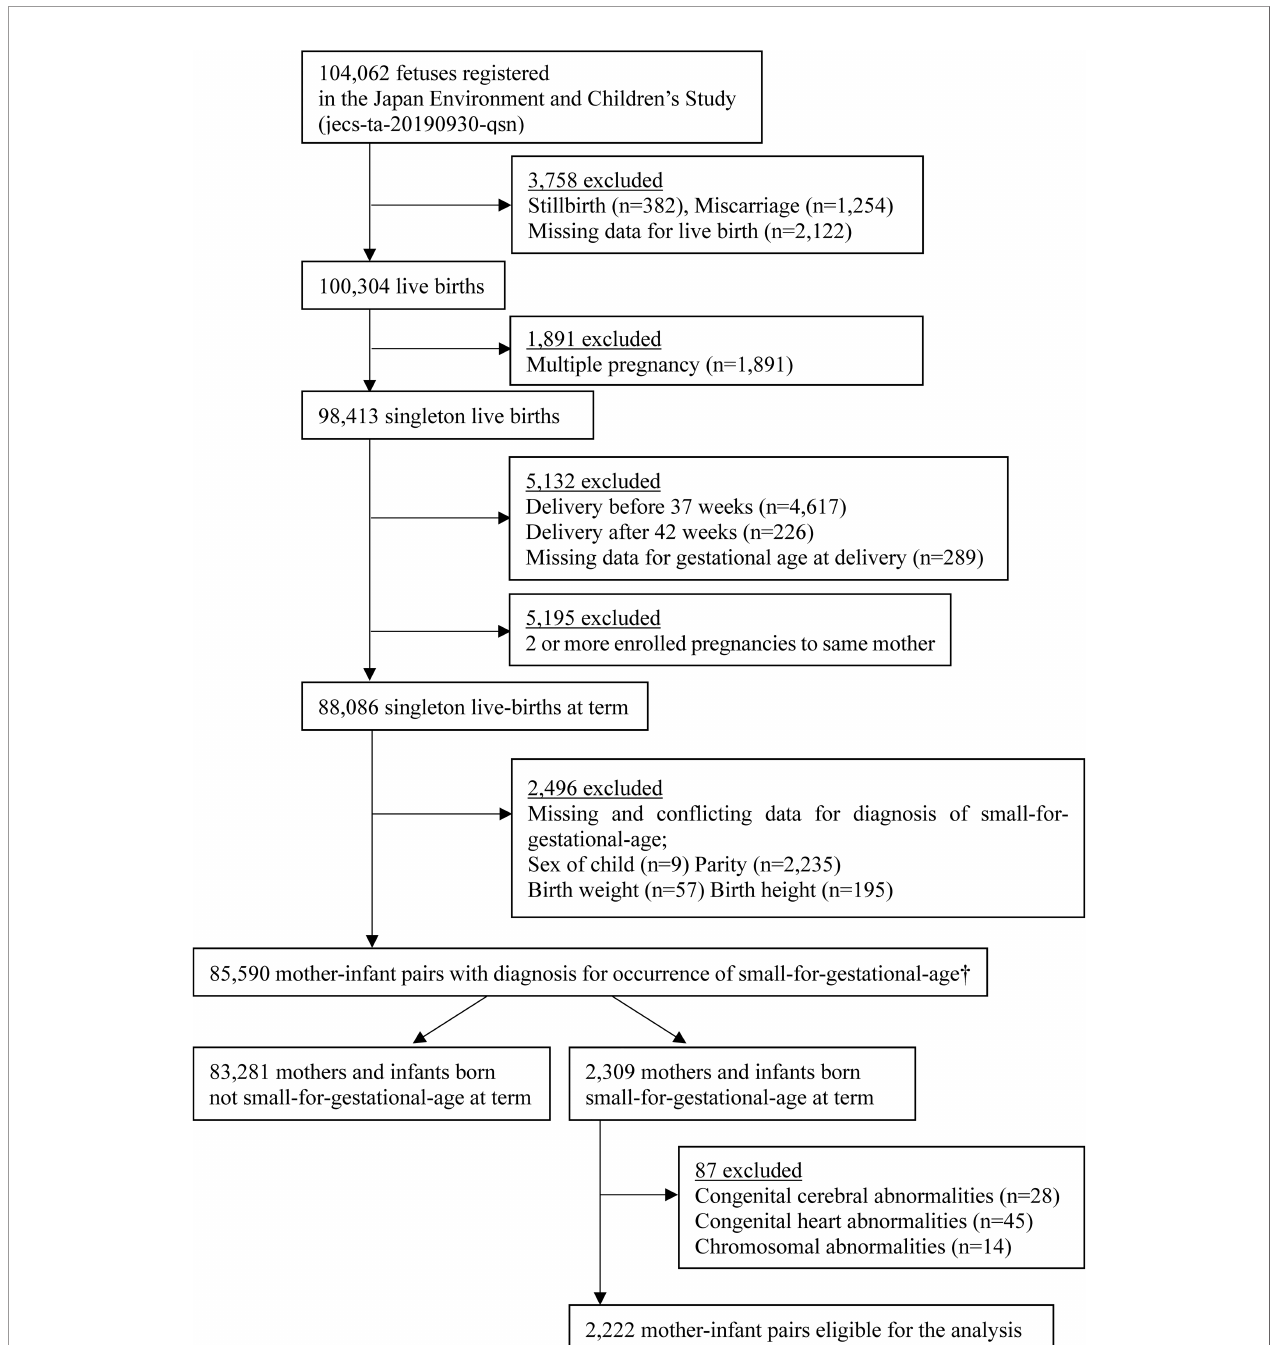
FIGURE 1 | Study enrollment fl